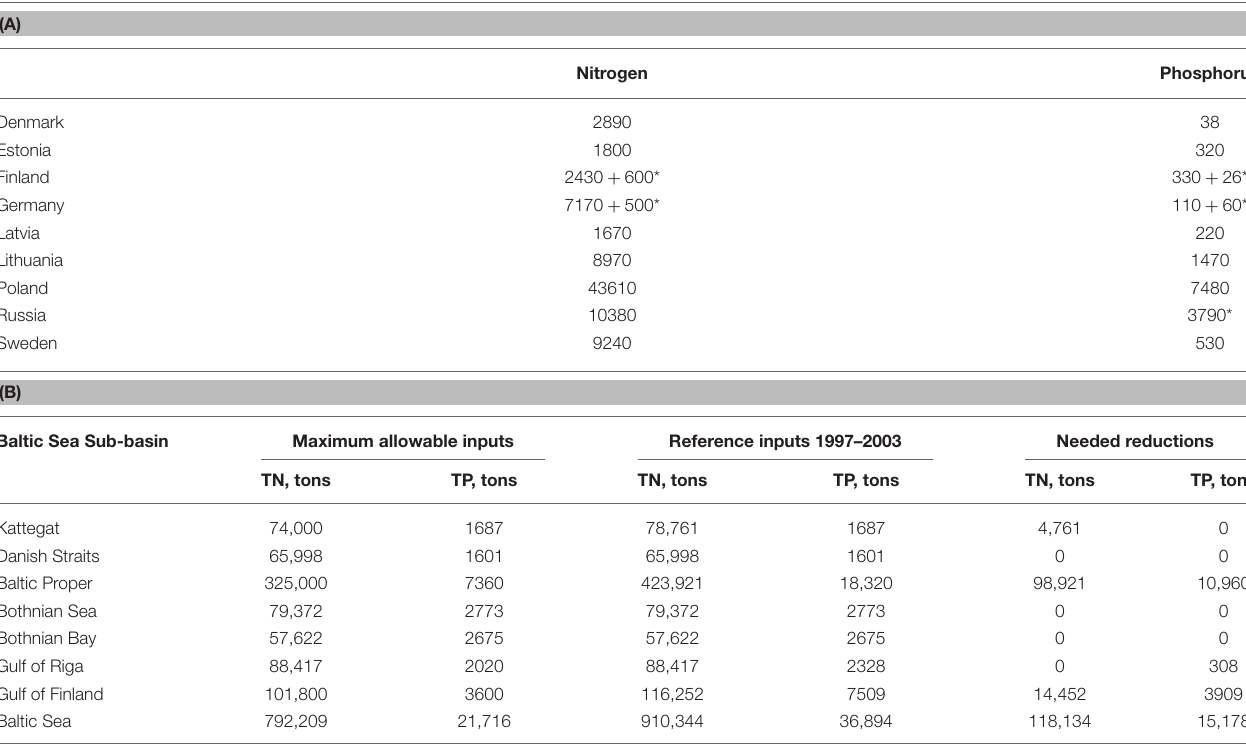
TABLE 1 | (A) Maximum Allowable Inputs (MAIs) to the Baltic Sea and (B) country allocated reduction targets (CARTs) as revised by HELCOM using the BALSEM model (HELCOM, 2013).